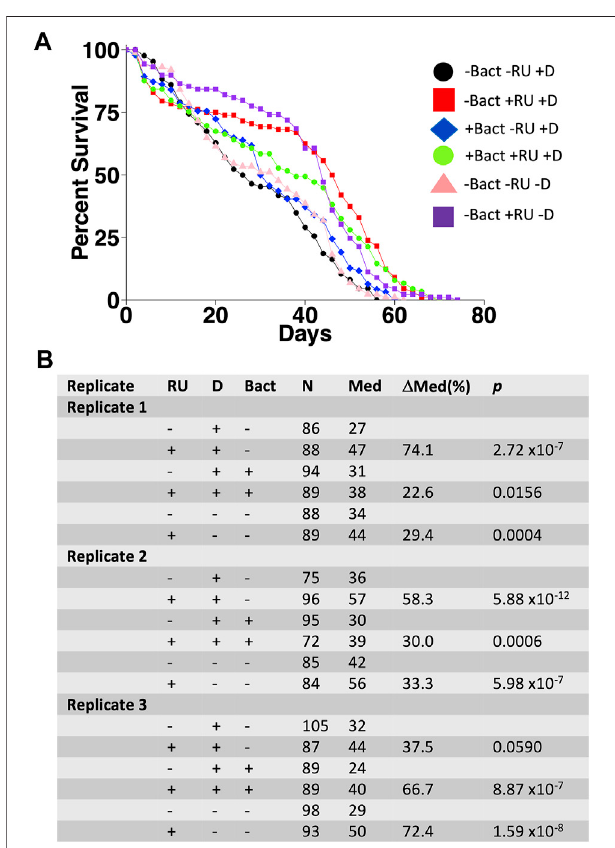
FIGURE 7 | Effect of Enterococcus faecalis supplementation on adult female life span. Flies with constitutive expression of sex peptide (genotype w [1118];dsx-GAL4/+; UAS-SP/+ ) were grown on media in absence (-D) and presence(+D)ofdoxycycline.Virginfemaleswerecollectedandassayed for life span in absence (-Bact) or presence (+Bact) of added Enterococcus faecalis , and in absence ( − RU) or presence (+RU) of 200 μ g/ml mifepristone/ RU486, in three replicate experiments. (A) Survival curves for experiment 1. (B) Statistical summary for experiments 1 – 3. For each experiment, +RU is compared to − RU. Statistical test: log-rank; p- value for signi fi cance with one comparisons is 0.05.